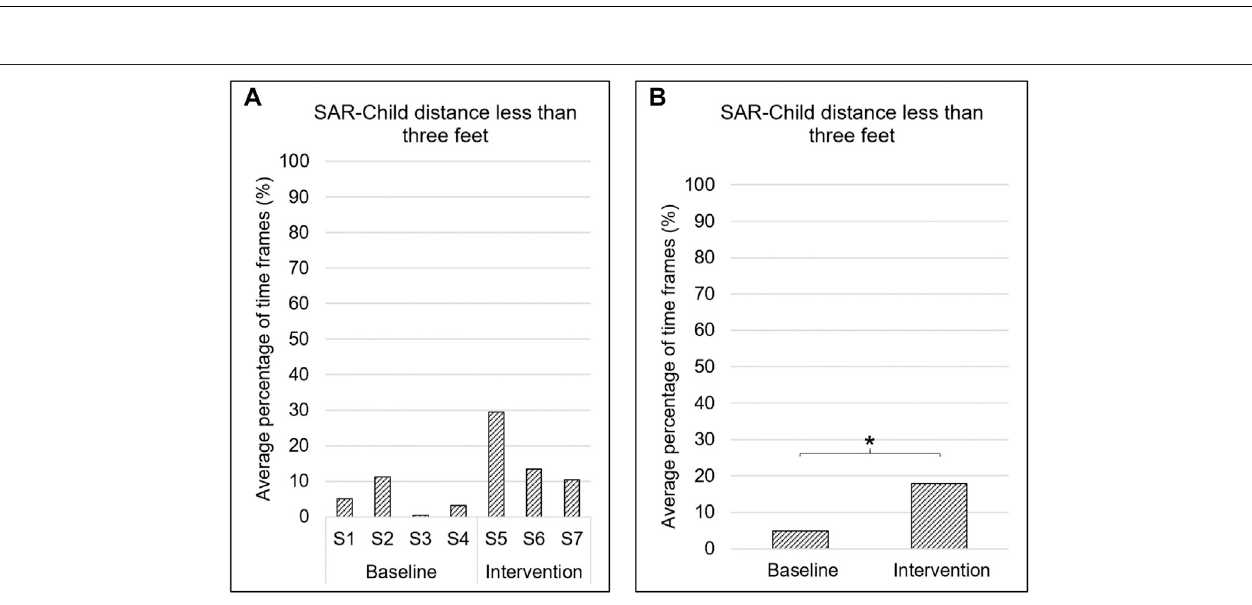
FIGURE5| SAR-childpositioning. A .Averagepercentage oftimeframeswhen childrenwerewithinthreefeetoftherobot.S#onthe x -axisrepresentsthesession number. B . Average percentage of time frames when children were within three feet of the robot during baseline and intervention phases. * → p < 0.05.